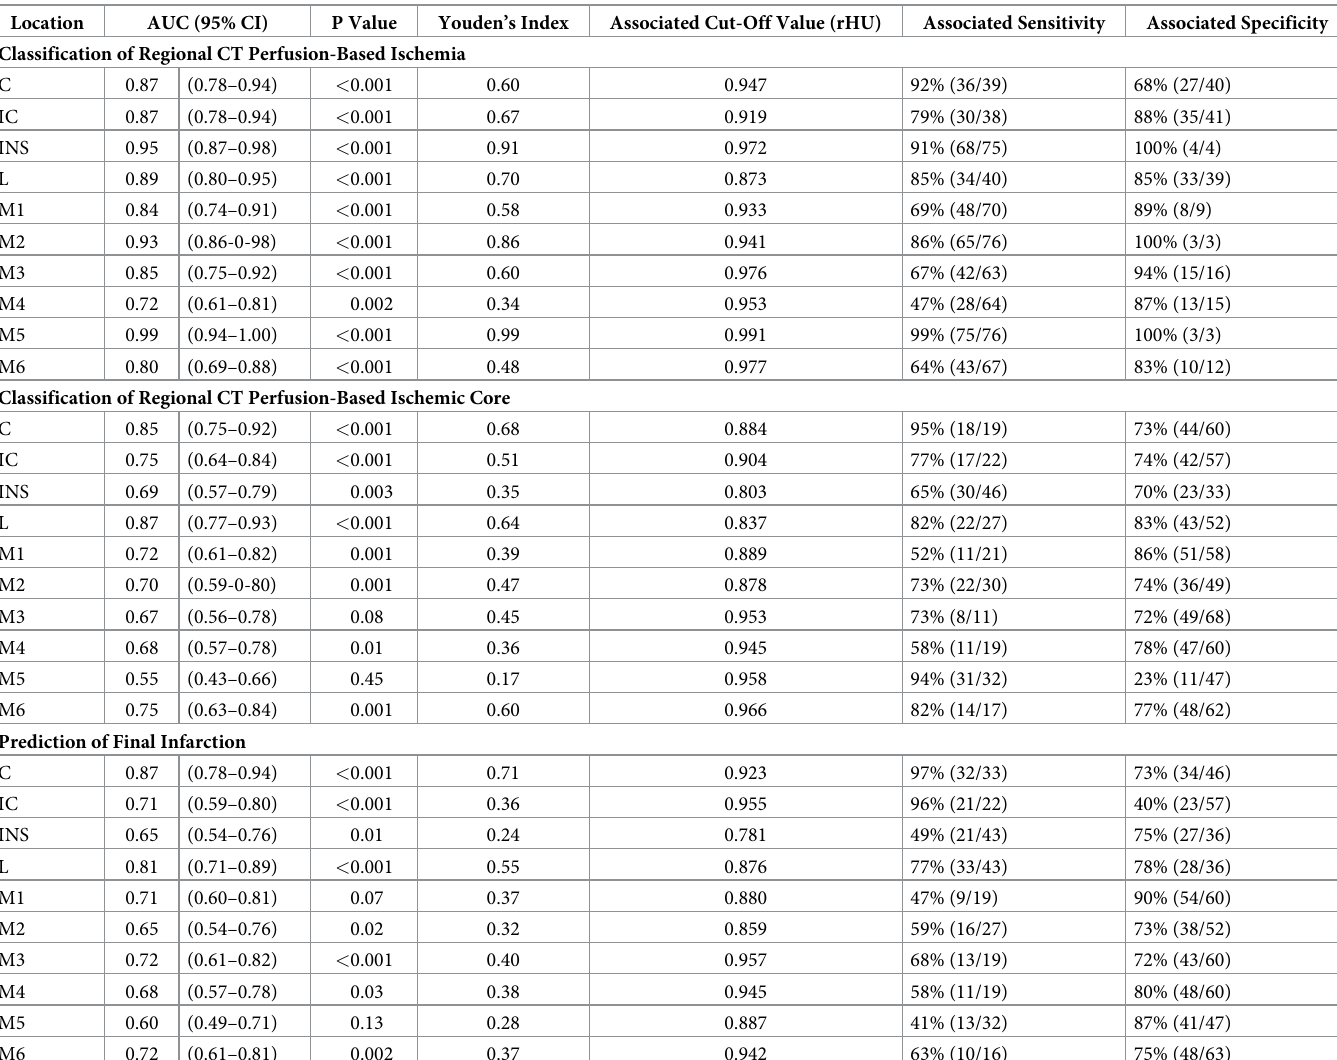
Table 3. ROC analysis of CTASI-rHU values for the classification of indicated